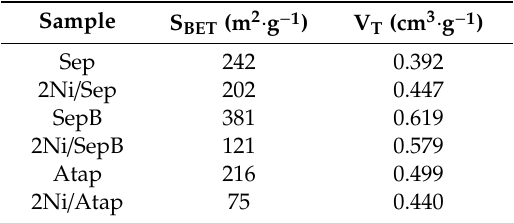
Table 2. Textural properties of the Ni-based catalyst supported on di ff erent